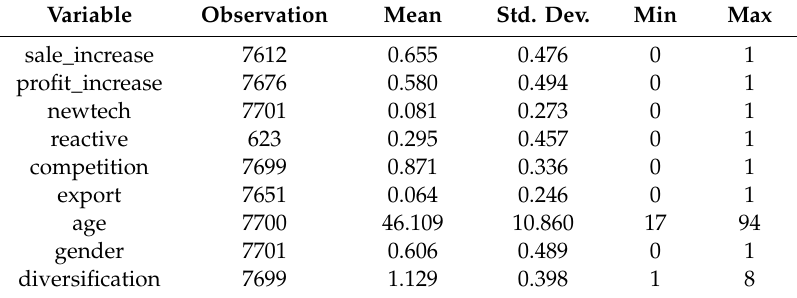
Table 2. Descriptive statistics.